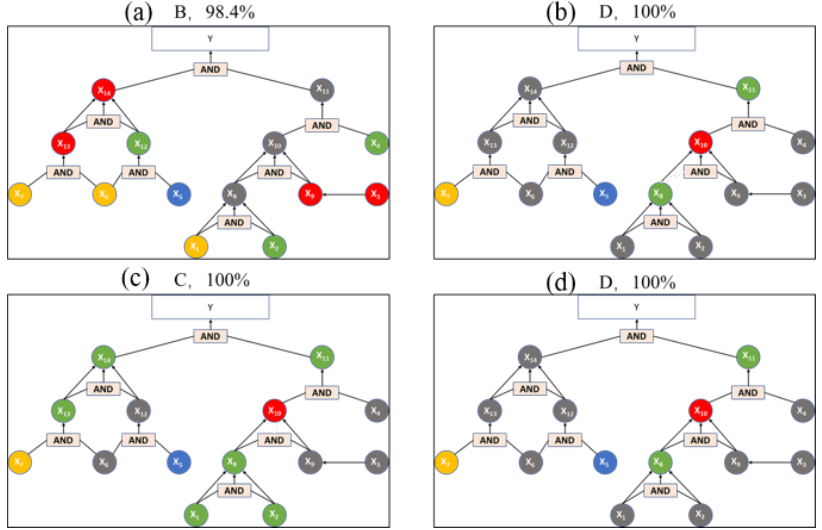
Figure 12. Partial training results of the un-labeled structure classification. ( a ) shows this spare part is 98.4% classified into class B; ( b ) and ( d ) indicate these two spare parts are 100% classified into class D; ( c ) shows this spare part is 100% classified into class C.As shown in Table 8, all four spare part levels have acceptable accuracy. For class A, the testing accuracy is 89.7% (higher than 50% in the supervised learning process) with the few-shot samples. This is slightly lower than the 97.5% achieved in the supervised learning process with additional samples, but still confirms that the proposed method is effective. The r and p results of this semi-supervised process are shown in Figure 13.